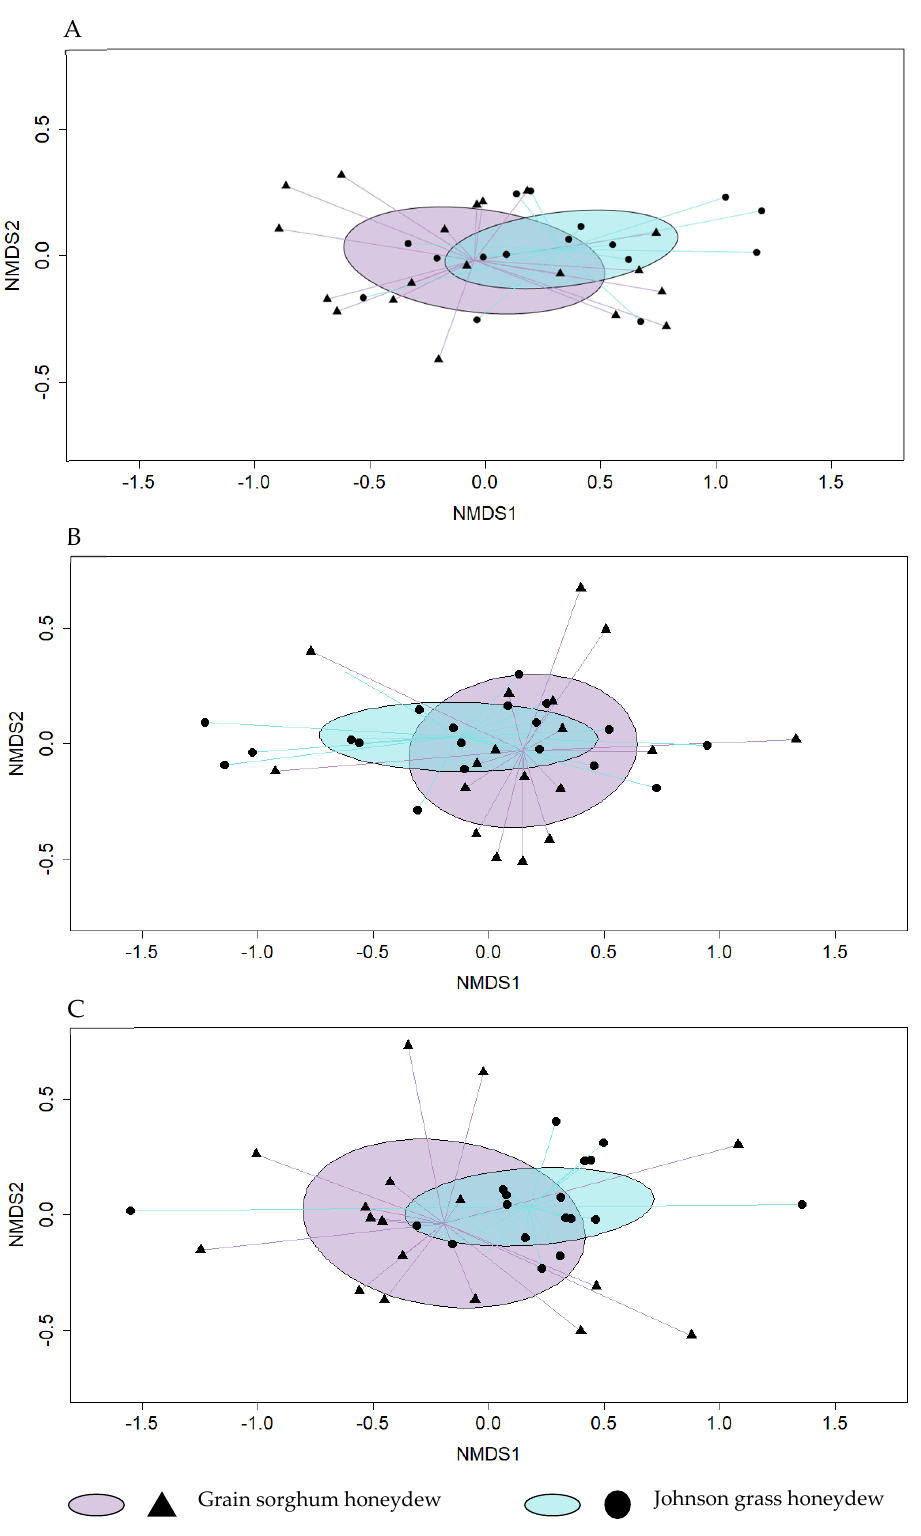
Figure 2. Non-metric multidimensional scaling (NMDS) ordination diagram. Sugar and organic acid profiles are similar between grain sorghum and Johnson grass honeydew collected after 24 h ( A ) and 72 h ( B ). Profiles are significantly different between grain sorghum and Johnson grass honeydew collected after 120 h (PERMANOVA F = 3.7925; df = 1,34; p = 0.01) ( C ). Ellipses represent 95% confidence intervals. Triangle and circle points ordinated closer to one another are more similar.